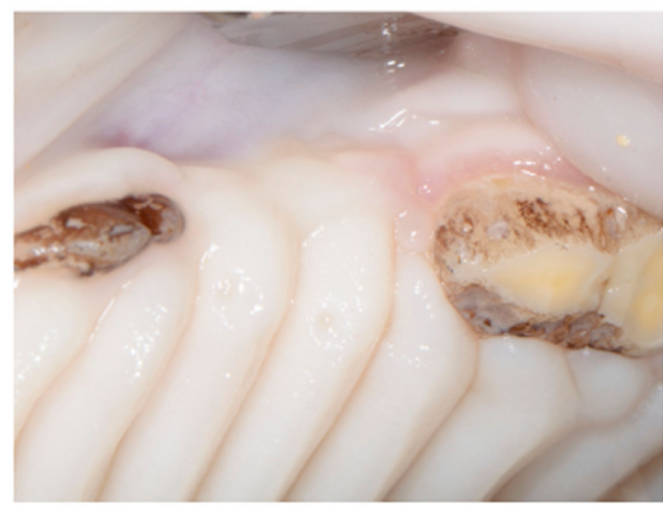
Figure 3. Normal healing after 12 weeks.